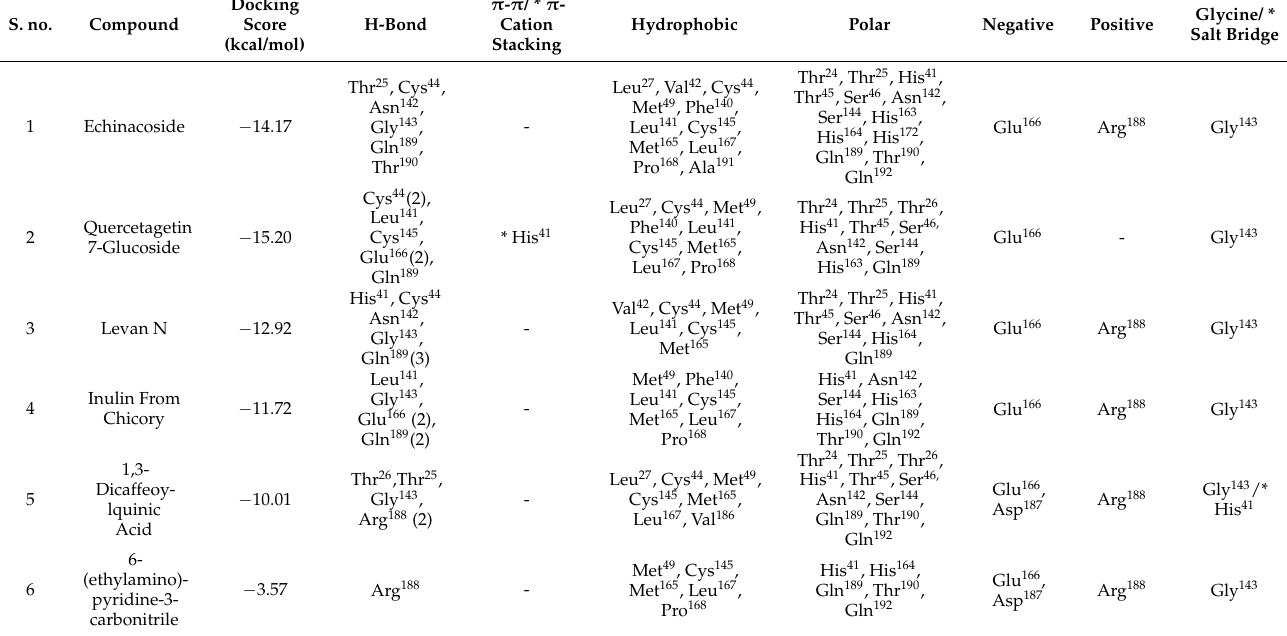
Table 1. Intermolecular interactions observed for the best poses of docked natural products against reference compounds in the catalytic pocket of SARS-CoV-2 M pro against the reference